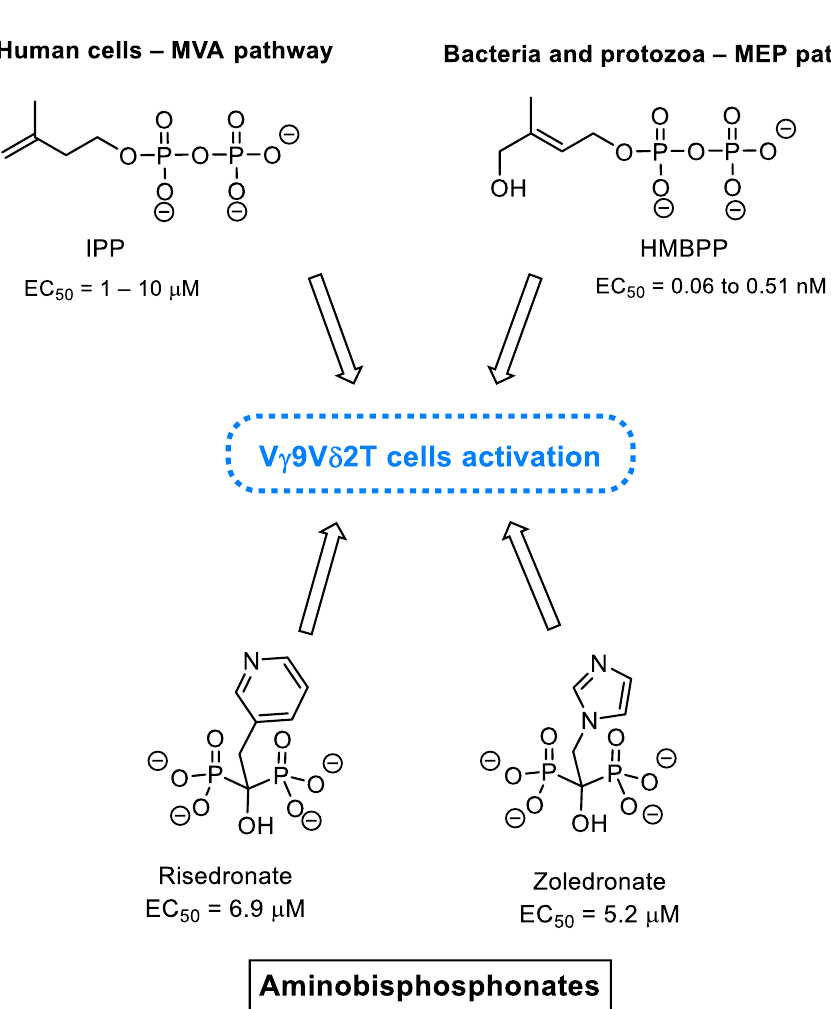
Figure 8. Natural phosphoantigens from the isoprenoid biosynthesis and aminobisphosphonates. MVA: mevalonate; EC 50 : half maximal effective concentration.